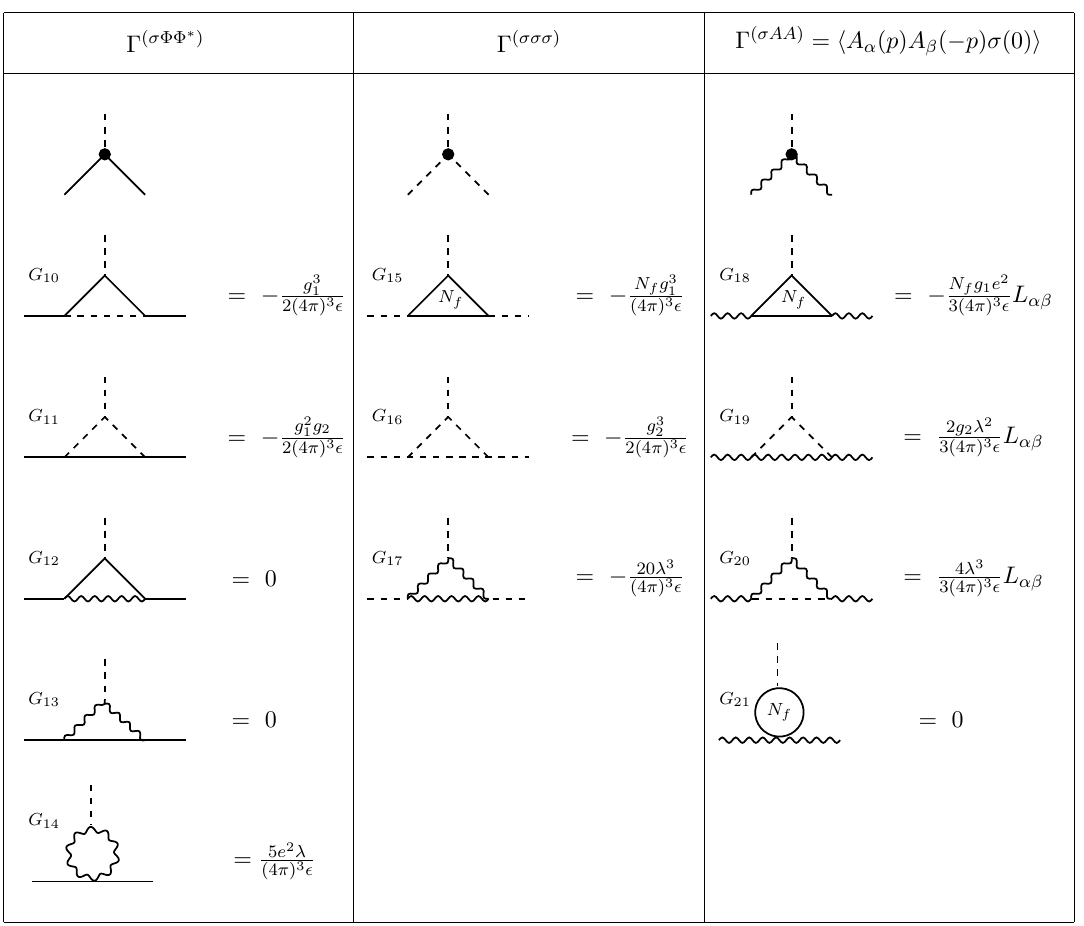
Table 3 . 3-point Green functions in the one-loop approximation. L (cid:11)(cid:12) = p (cid:11) p (cid:12) (cid:0) (cid:14) (cid:11)(cid:12) p 2 .